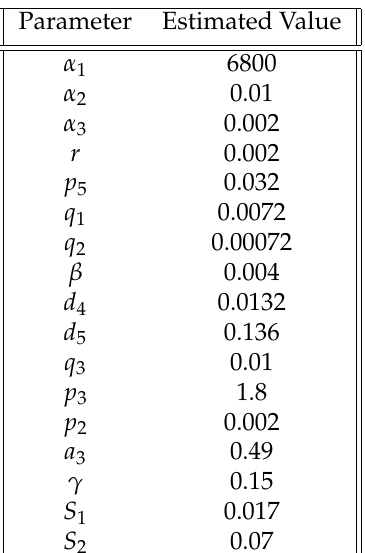
Table 1. Parameters Used in Numerical Simulations